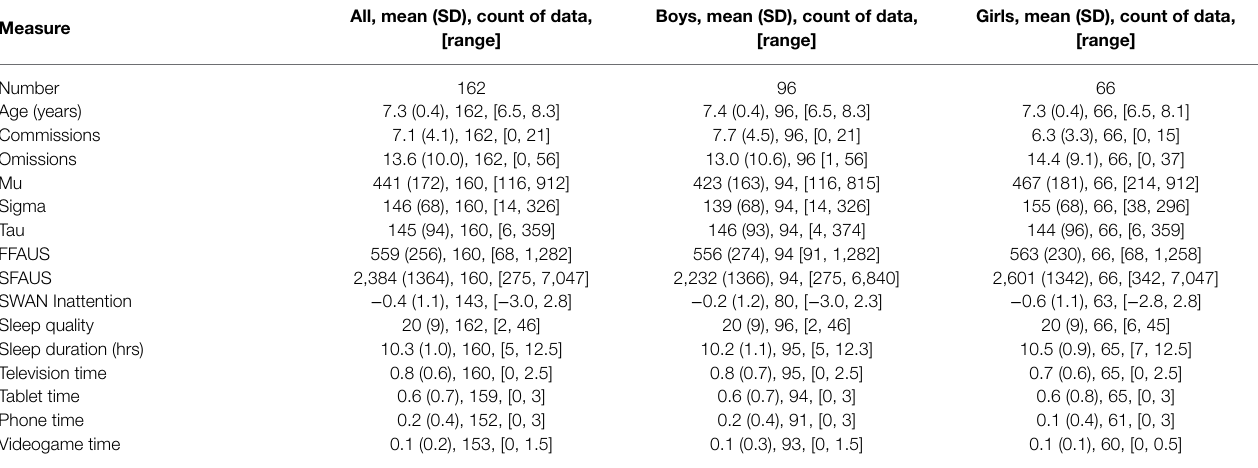
TABLE 1 | The descriptive statistics for the sample and each of the outcome measures. Measure